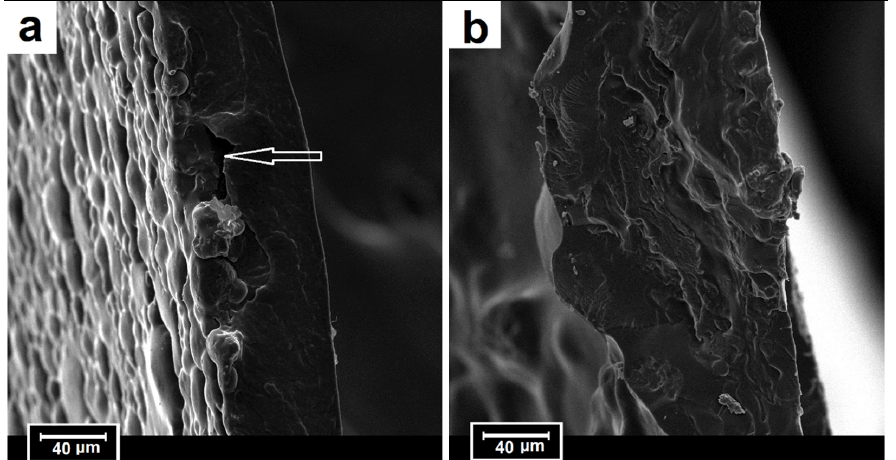
Figure 9. SEM observations of the fractures: ( a ) TPS/P and ( b ) TPS/PH.